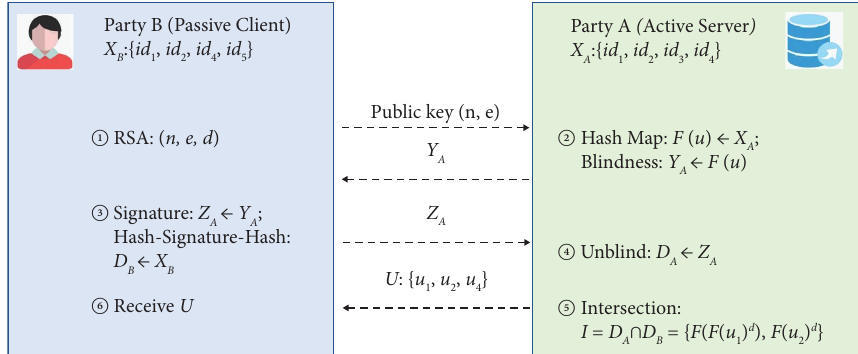
Figure 3: Demonstration of private set